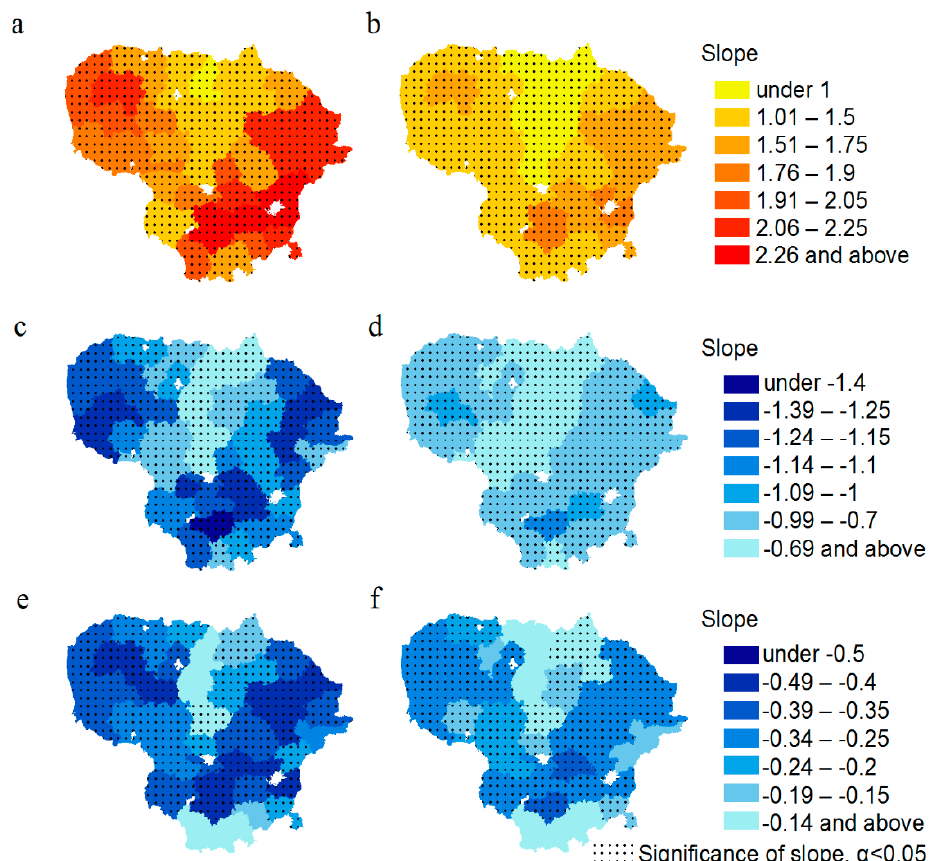
Figure 6. Pattern of climate change effects on selected dendrometric attributes in Lithuanian forests during next 100 years from 2020 to 2120: ( a ) Standing volume in 1 ha, REFERENCE scenario, ( b ) standing volume in 1 ha, EU BIOENERGY scenario, ( c ) average diameter of all forest stands, REFERENCE scenario, ( d ) average diameter of all forest stands, EU BIOENERGY scenario, I annual wood volume increment, REFERENCE scenario, ( f ) annual wood volume increment, EU BIOENERGY scenario.